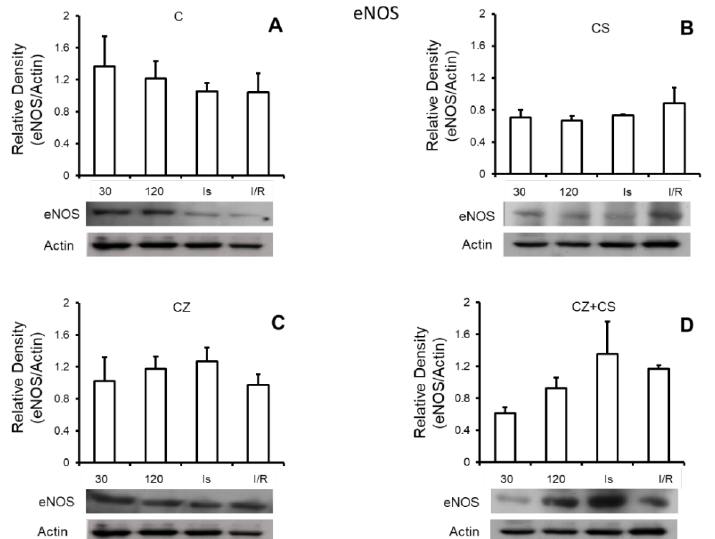
Figure 5. eNOS expression in isolated hearts from control (A) and treated animals with CS (B), CZ (C) and CZ+CS (D) and exposed to different perfusion times (30 min and 120 min), ischemia (Is) (30 min) and ischemia-reperfusion (I/R)(60 min). Values are the mean ± SE ( n = 5 in each group p ≤ 0.05).